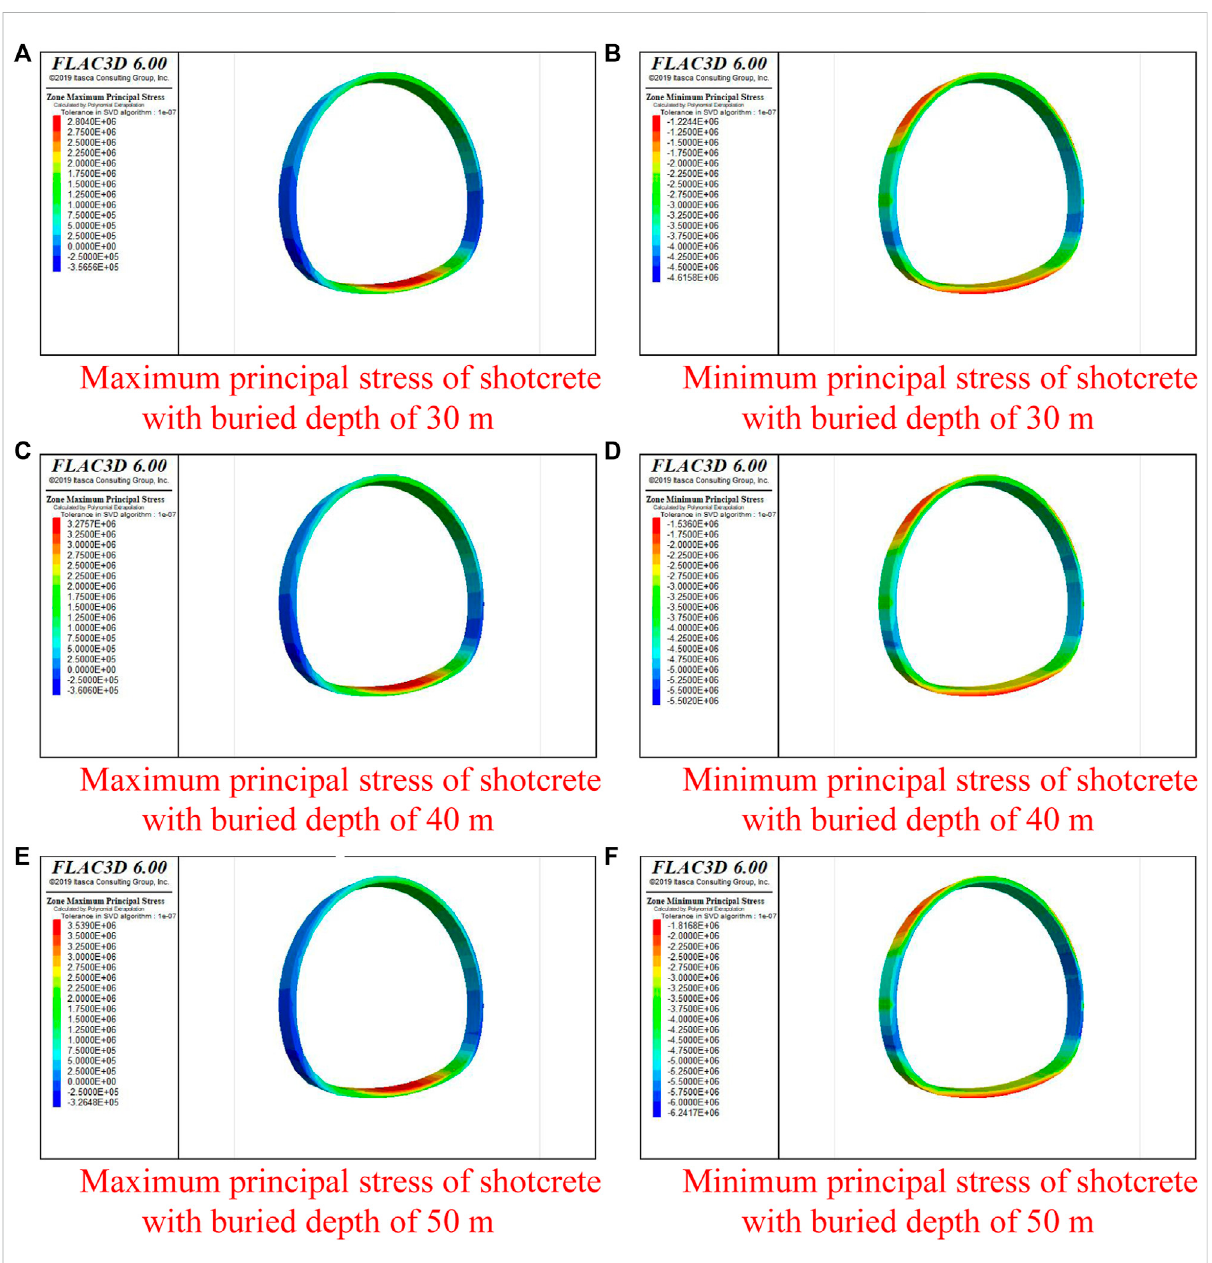
FIGURE 15 Cloudchartofmaximumandminimumprincipalstressesofshotcreteatdifferentburialdepths. (A) Maximumprincipalstressofshotcretewitha burial depth of 30 m, and (B) minimum principal stress of shotcrete with a burial depth of 30 m. (C) Maximum principal stress of shotcrete with a burial depth of 40 m, and (D) minimum principal stress of shotcrete with a burial depth of 40 m. (E) Maximum principal stress of shotcrete with a burial depth of 50 m, and (F) minimum principal stress of shotcrete with a burial depth of 50